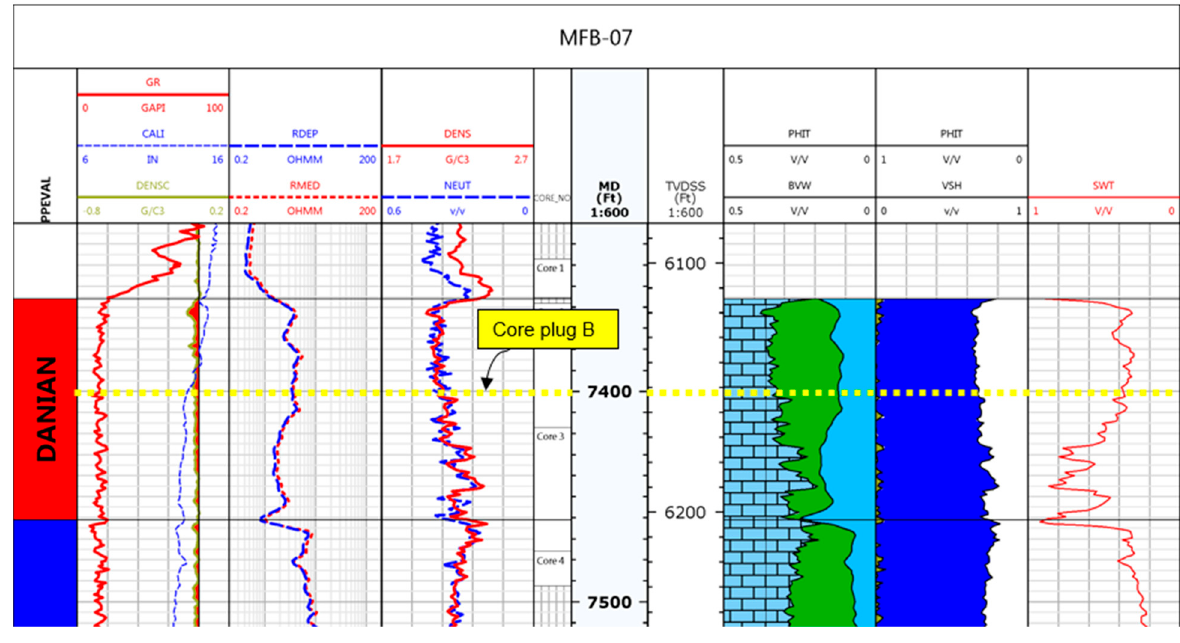
Figure 1. The measured depth (7399 ft) of core plug B from well MFB ‐ 7, Danian age, Ekofisk formation. The slices from this core plug were used in experiments 4 to 6. Table 3. Petrophysical characteristics of core plugs. Length L, diameter D, permeability K,